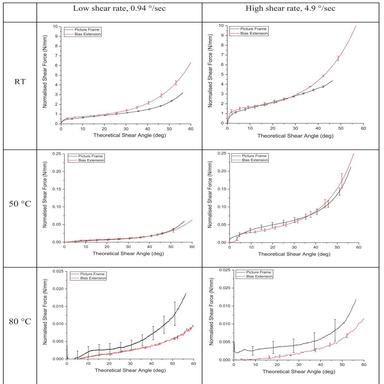
Normalization of BE and PF test results of the CEP-TW1 (Prepreg Solvalite 730) for the selected test-conditions of temperature and shear rates.